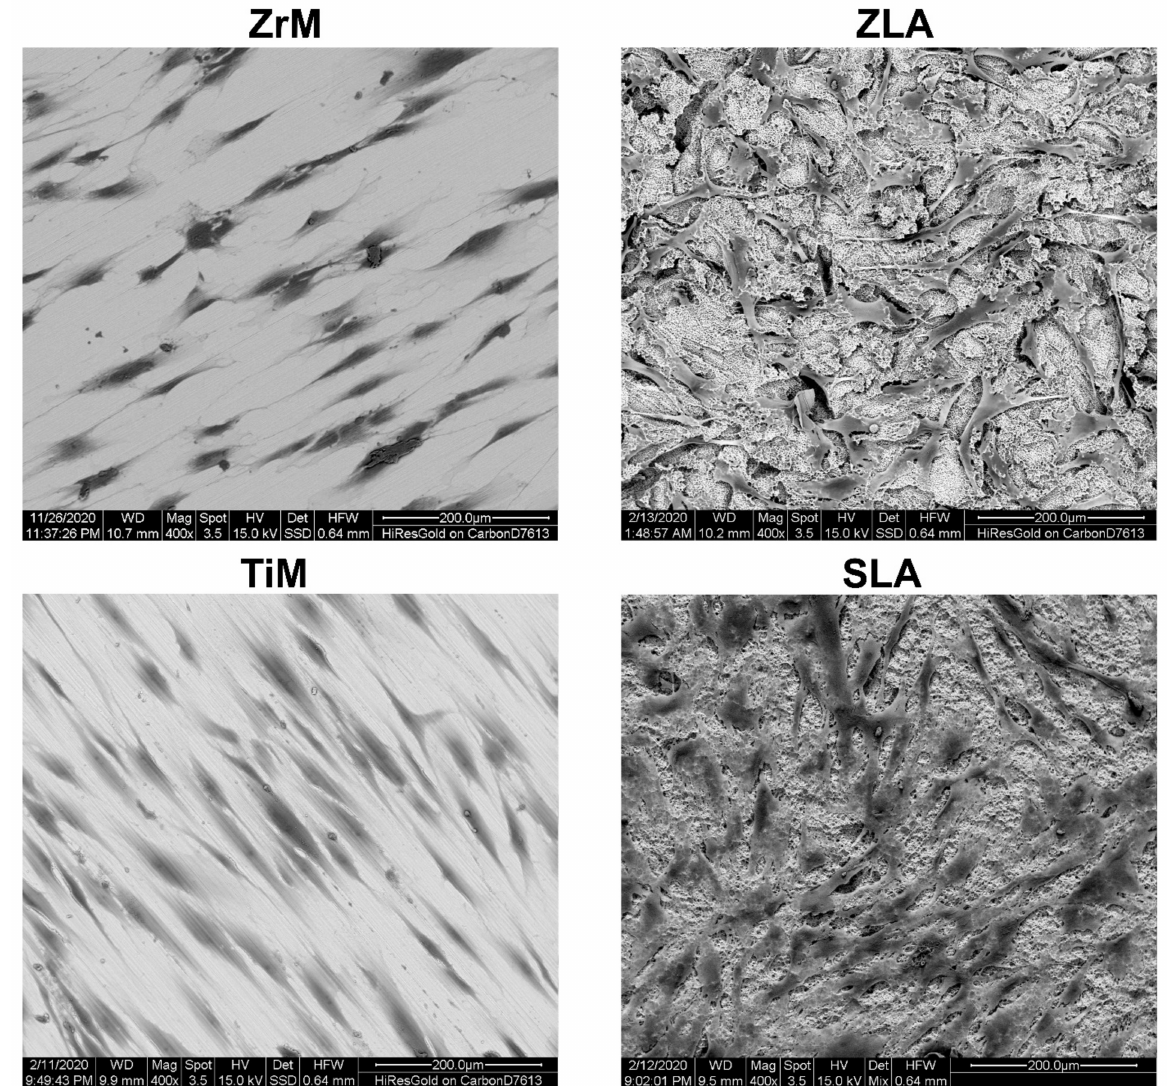
Figure 2. Scanning electron microscopy analysis of hGFs grown on ZrM, ZLA, TiM and SLA. hGFs after 2 days of culture. Scale bar = 200 µ